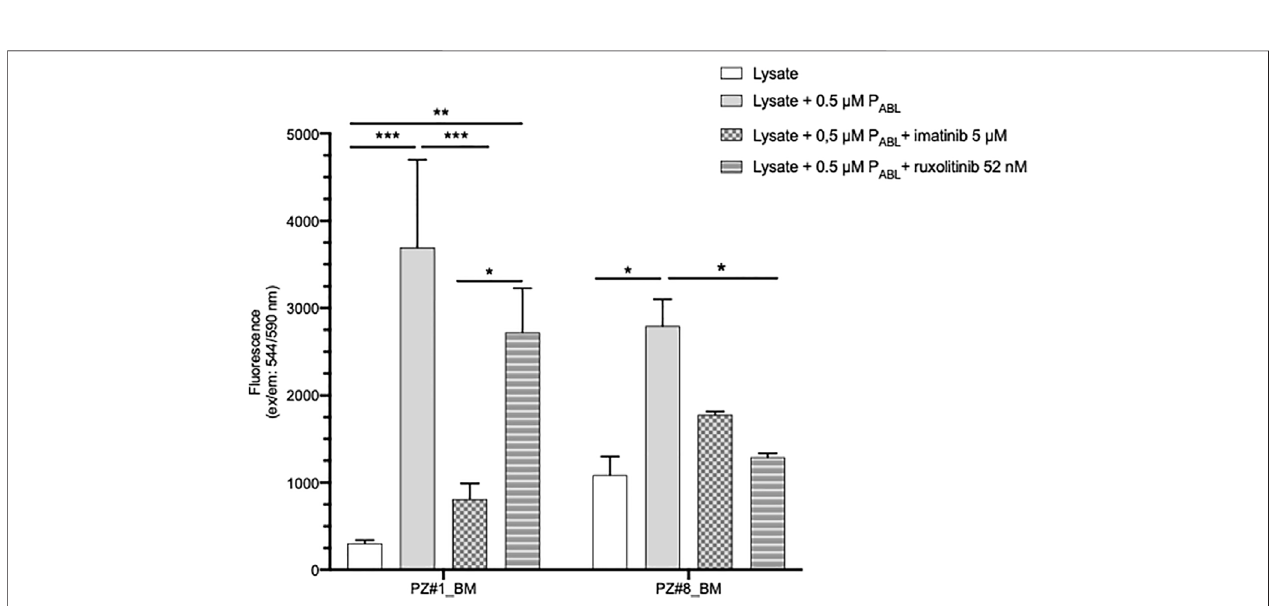
FIGURE 7 | P ABL -based ELISA assay in patients ’ primary cells lysates. Pt#1 is an adult male patient affected by CML (p210 BCR-ABL1 positive); Pt#2 is a female childaffectedby BCR-ABL1 negativeALL( BCR-ABL1like translocationsnotknown).Fluorescencevaluesinordinate. p -valueaccordingtotwo-wayANOVA,Bonferroni post-test for multiple comparison: ***, < 0.001; **, < 0.01, * < 0.05.